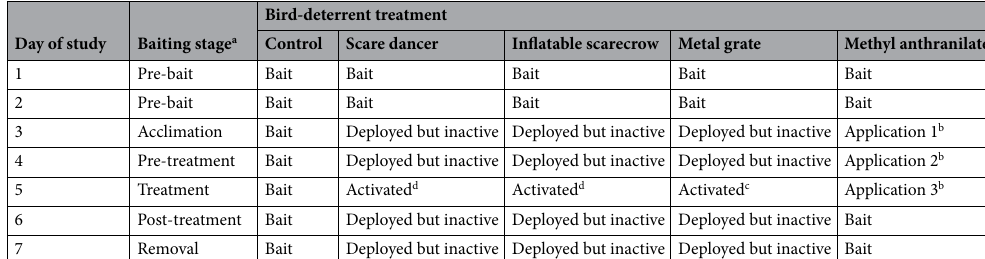
Table 1. Strategies used to evaluate effectiveness of bird deterrents during a 7-day trial in north-central Colorado, USA during April–May 2020. a For all stages, 2 kg of store-bought bird seed (Wild Birds Unlimited Deluxe Blend, Fort Collins, CO, USA) was deployed daily at each bait site. Any remaining bird seed from the previous day was removed. b A spot treatment application of Avian Migrate (containing 14.5% methyl anthranilate) mixed into 50% water was applied to the ground in a ~ 3 × 3 m area. Then, the 2 kg of bird seed was dispersed over the treated area. c The metal grate was placed over top of the 2 kg pile of bird seed upon deployment until the operators arrived the following day (i.e., ~ 1200 h). c The inflatable scarecrow and scare dancer were programmed to activate starting at 1 h before first light. The devices remained activated until operators arrived to re-deploy bird seed the following day (i.e., ~ 1200